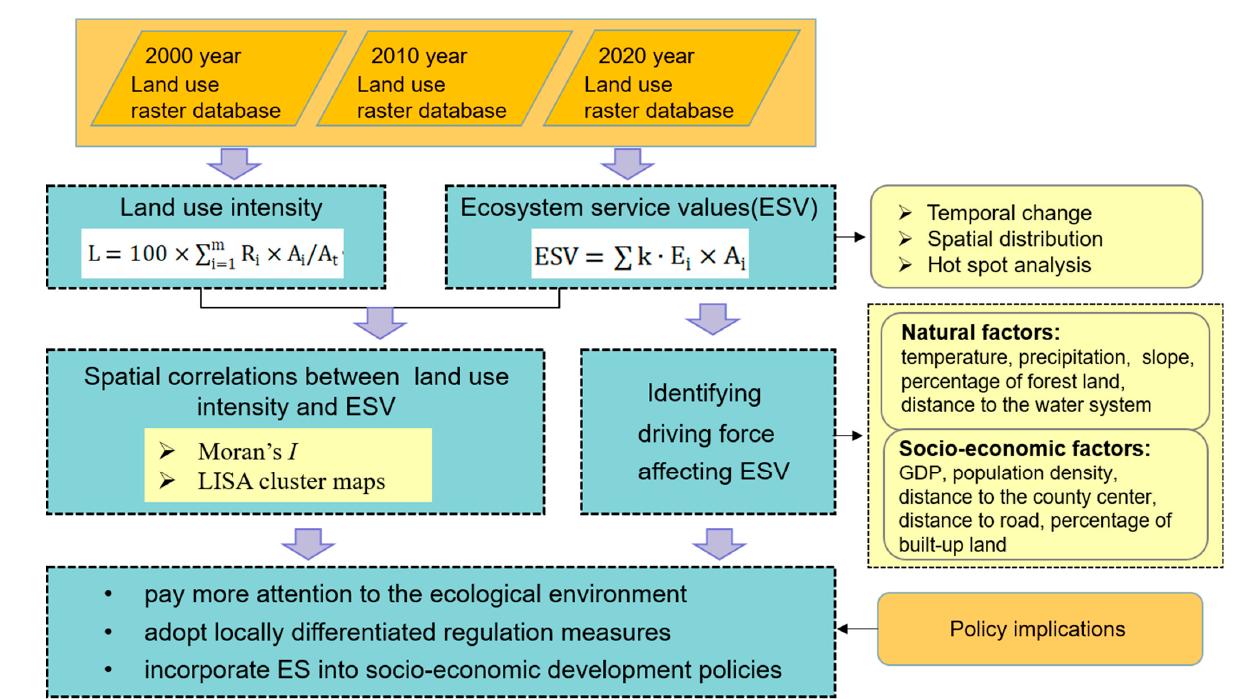
Figure 2. The framework of this